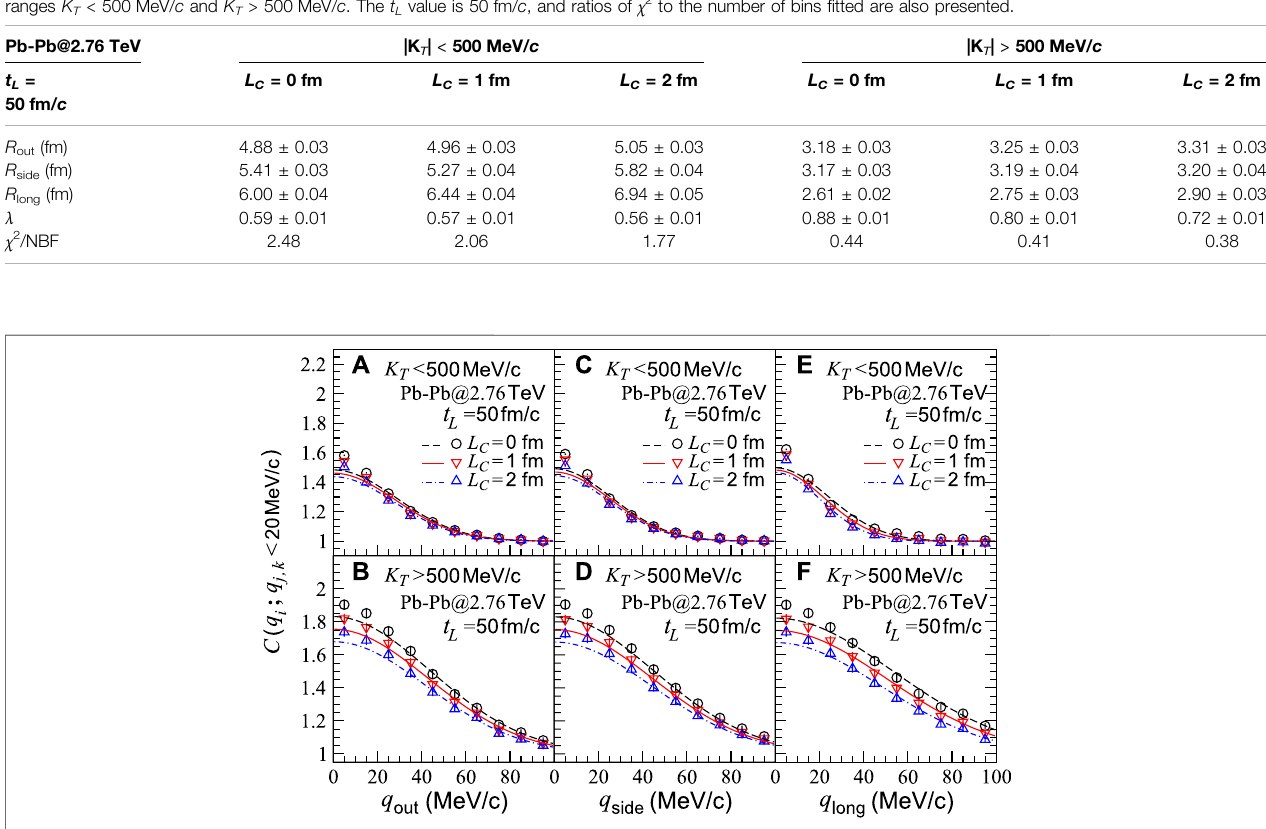
(cid:1)(cid:1)(cid:1)(cid:1) √ (cid:3) 2 . 76 TeV, in transverse momentum s NN